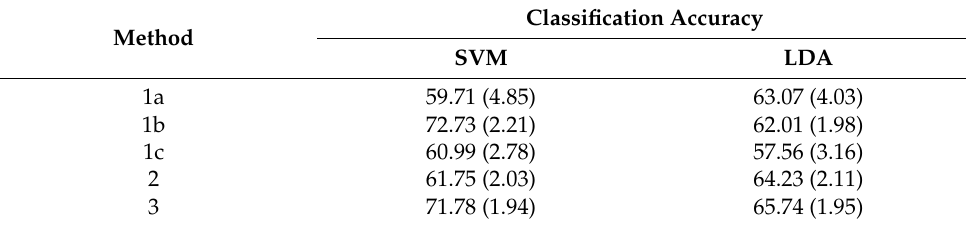
Table 4. The mean (standard error) classification accuracy from support vector machine (SVM) and linear discriminant analysis (LDA) classifiers for each method when using the time- and frequency- domain feature set.